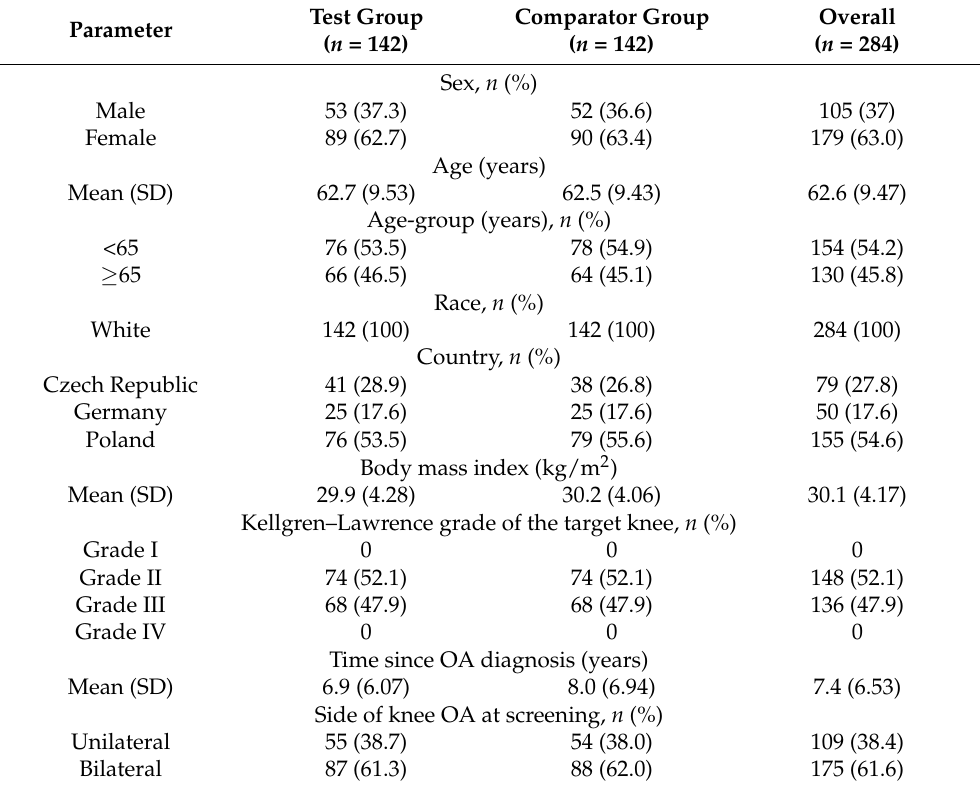
Table 1. Demographic characteristics (full analysis